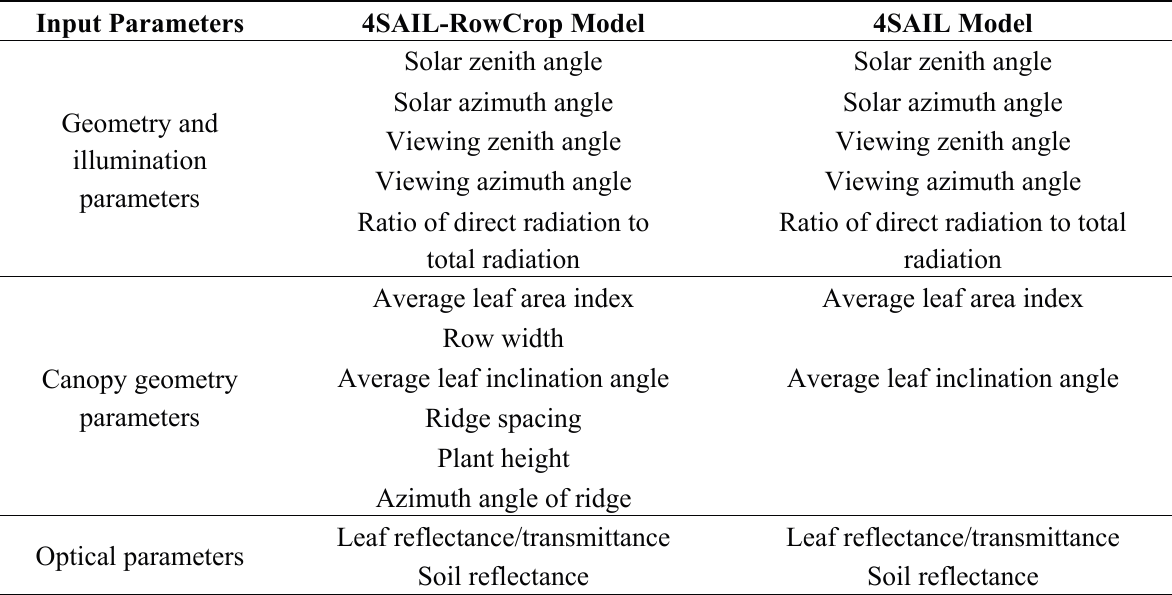
Table 7. Input parameters in the 4SAIL-RowCrop model and the 4SAIL